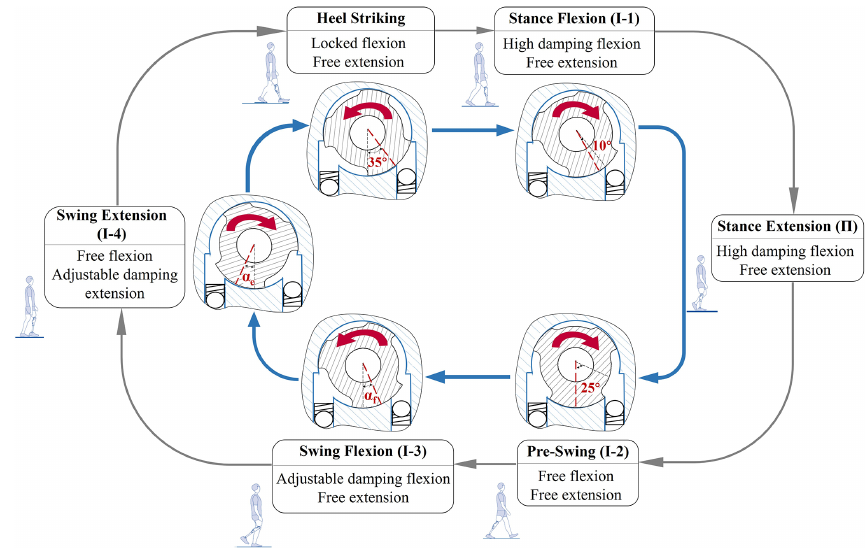
Figure 7. Damping control strategy.